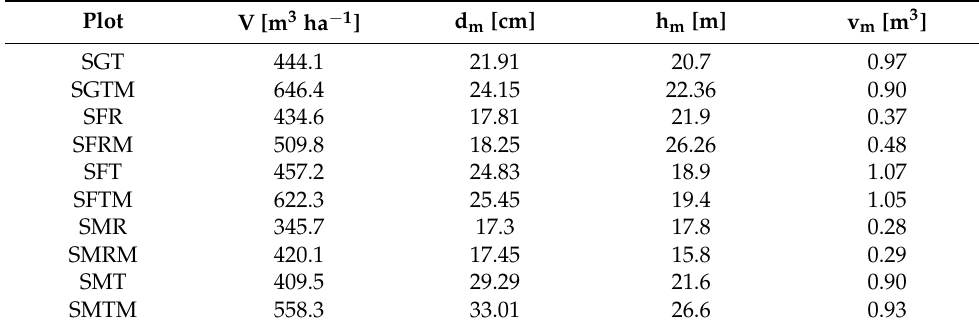
The above-ground volumes for each plot are presented in Table 2. When compared to the field measurements based on the same methodology (Equation (1)), the errors are between 4.6% and 13.3%. Table 2. Above-ground volume and mean stand characteristics. Table 2. Above-ground volume and mean stand characteristics. Plot